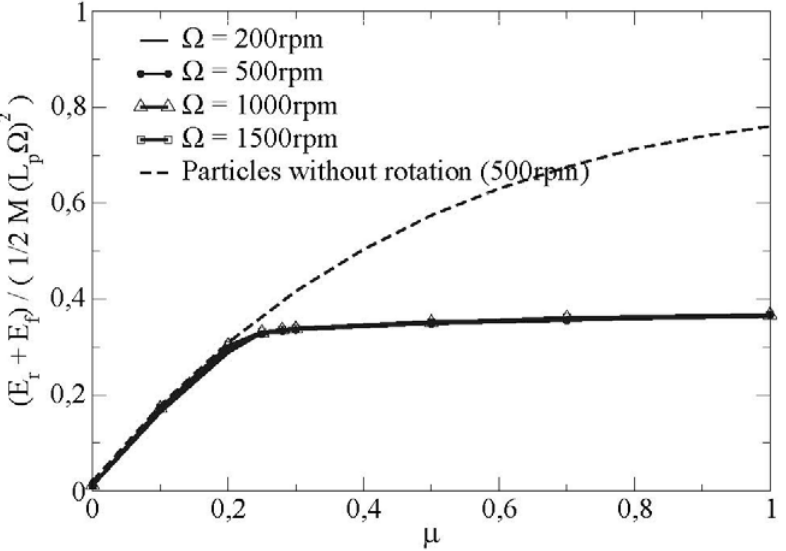
Figure 12. Comparison of the sum of the energy dissipated by friction E at a distance x = 166 R for particles with and without rotational energy of rotation E r degrees of freedom (variation of Ω , μ ’ =